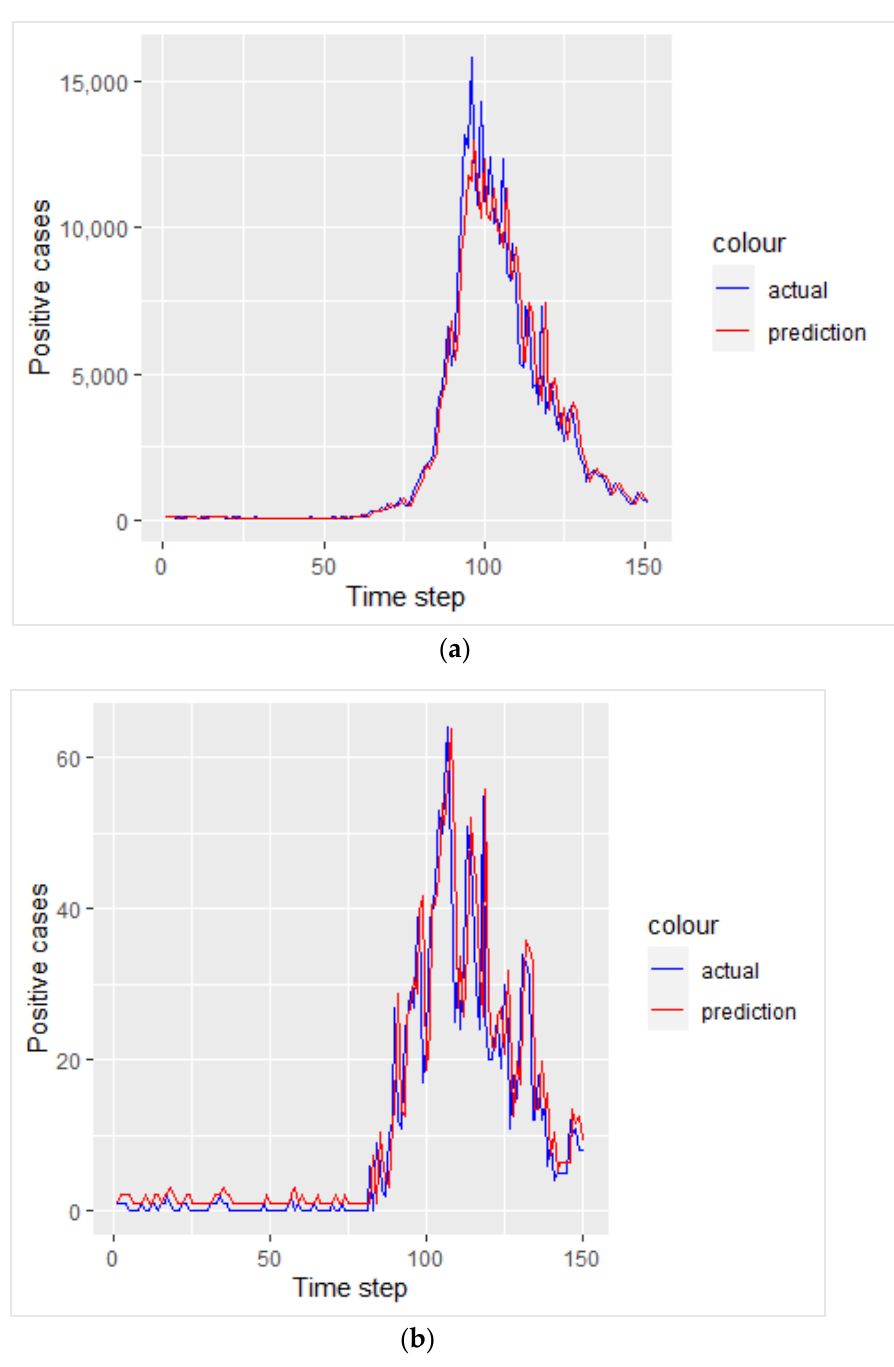
Figure 8. ( a ) Plot of actual data and predicted data for positive cases; and ( b ) plot of actual data and predicted data for death cases due to COVID-19.